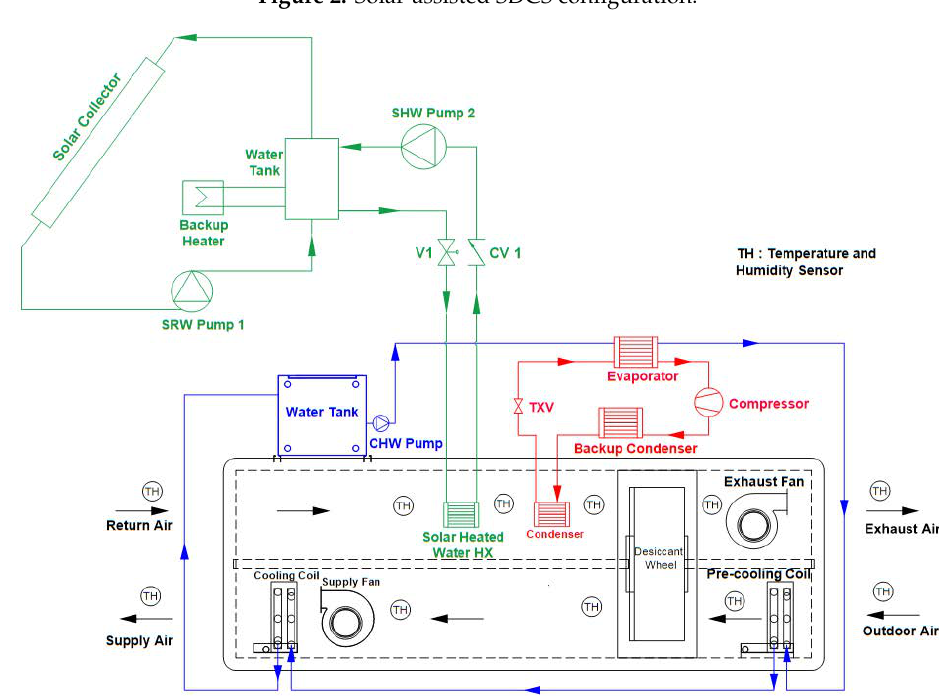
Figure 3. Solar-assisted hybrid SDCS